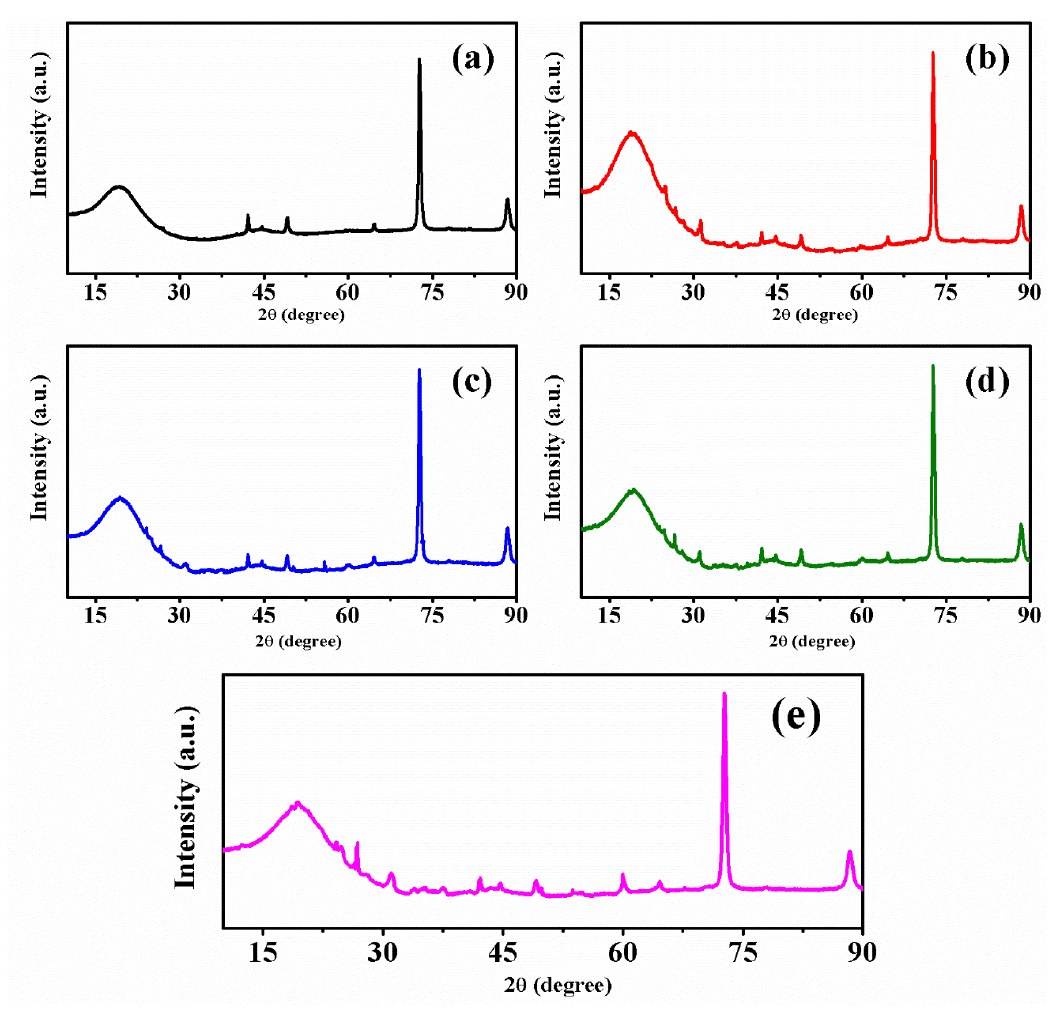
Figure 3. Composite diffractogram: PU/VMT 0% ( a ), PU/VMT 5% ( b ), PU/VMT 10% ( c ), PU/VMT 15% ( d ), and PU/VMT 20% ( e ).